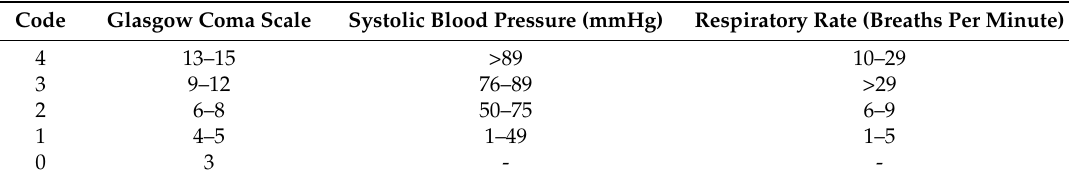
Table 2. Revised Trauma Score